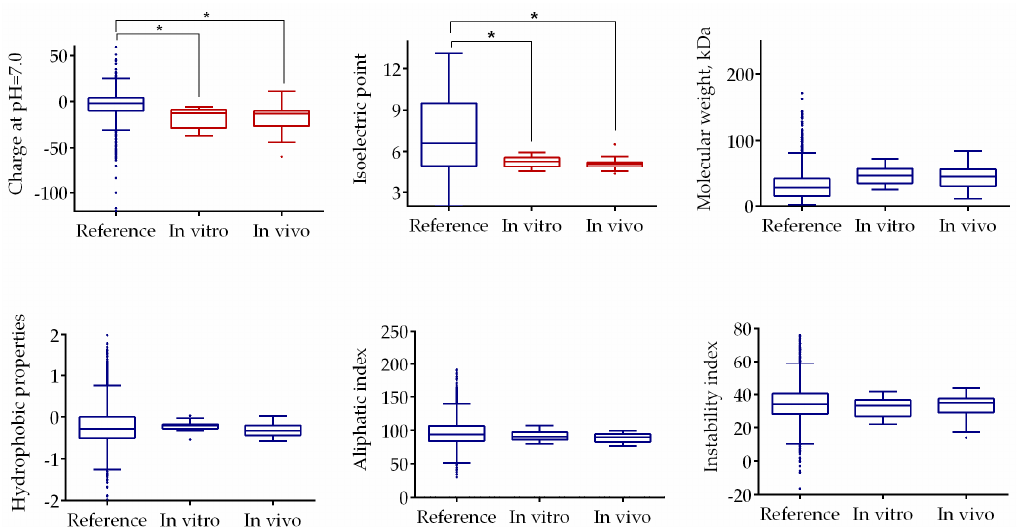
Figure 8. Comparison of physical and chemical properties of the putative substrates for the interaction with F105 with translated S. aureus proteome. Asterisks denote statistically significant differences of medians (* p < 0.05).